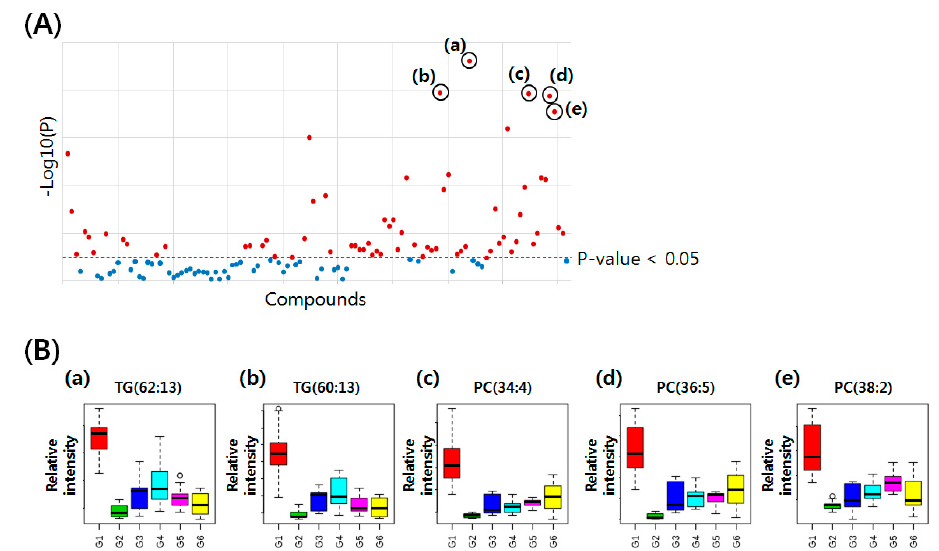
Figure 5. ( A ) ANOVA representing the statistically altered compounds among the 120 lipids from thirty individual samples of G1–6 ( p value < 0.05). The most significantly altered five lipid were—( a ) TG (62:13), ( b ) TG (60:13), ( c ) PC (34:4), ( d ) PC (36:5), and ( e ) PC (38:2). ( B ) The bar plots